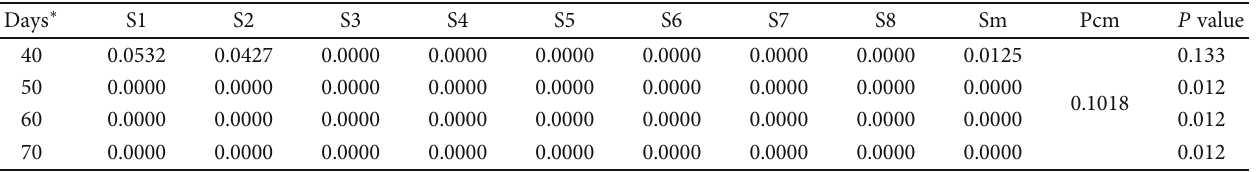
Figure 4: Tyrosine curves: (a) standard (0.5 μ g/ml) and (b) tyrosine serum level in a sample (at day 40). Dopamine curves: (c) standard (0.5 μ g/ml) and (d) dopamine serum level in a sample (at day 40). Table 1: Tyrosine serum level in mice after parasite